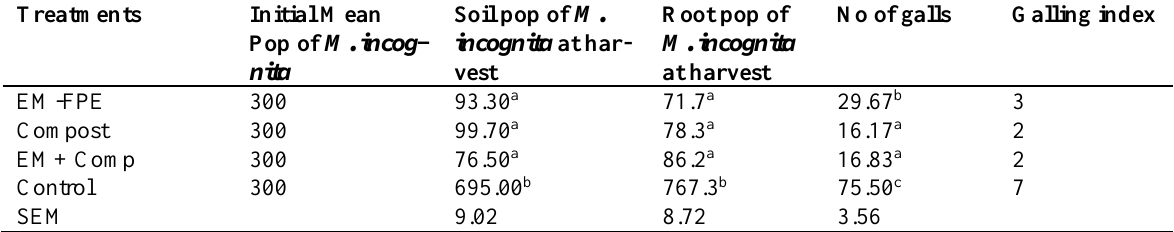
Table 7 Effect of treatment on soil and root populations of Meloidogyne incognita in the rhizosphere of tomato plants under field conditions Treatments